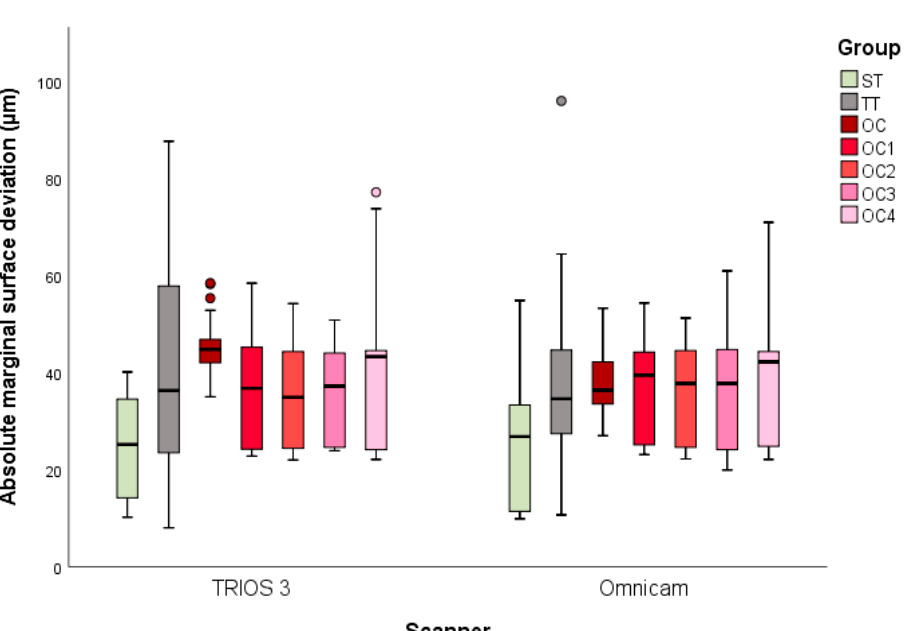
Figure 5. Box and whisker plots of the minimum, maximum, interquartile range, median, and outliers for the absolute marginal surface deviations.